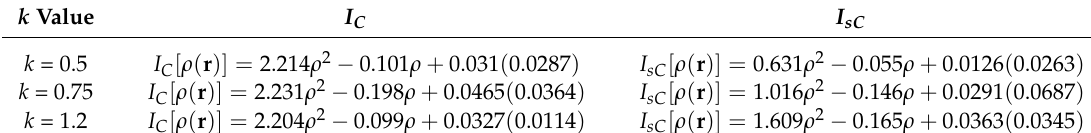
Table 1. Polynomial Fits for I C and I sC values (with RMS errors in parenthesis) for 1D including the spin. k Value I C I sC k = 0.5